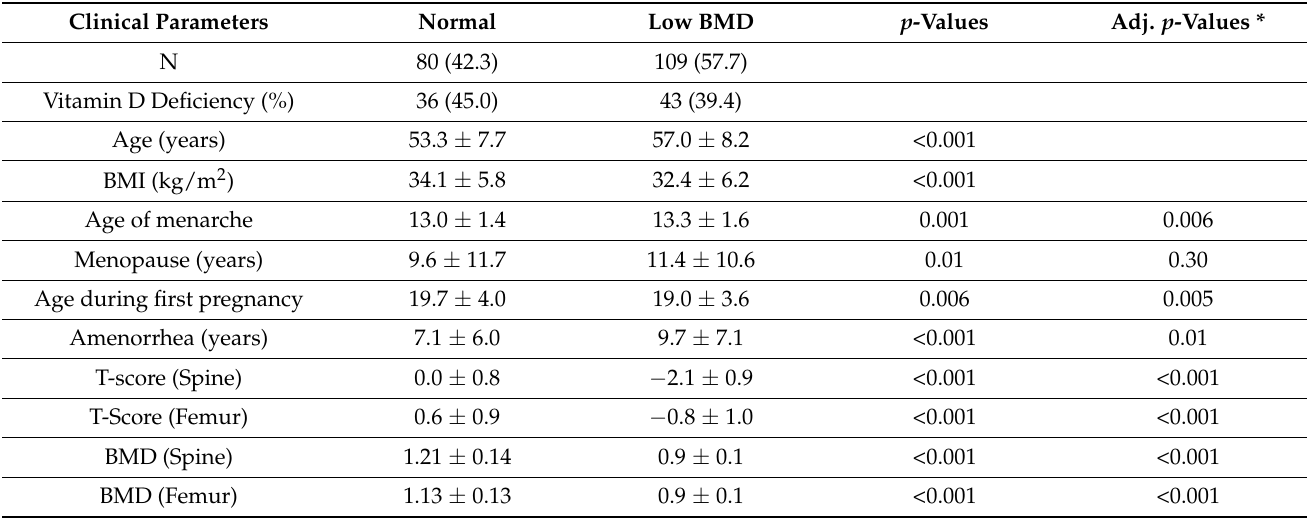
Table 1. General Clinical Characteristics of Participants according to Normal and Low Bone Mineral Density (BMD) Groups. Clinical Parameters